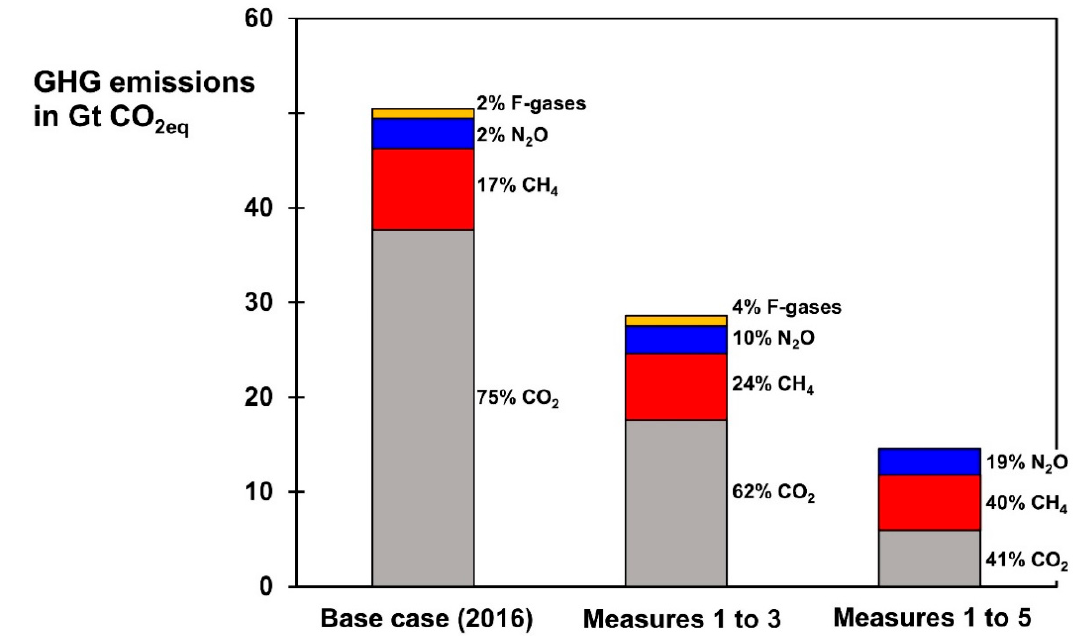
Figure 3. Global GHG emissions and shares of CO 2 , CH 4 , N 2 O and F-gases in base case (2016) and if measures 1 to 3 or 1 to 5 are taken (constant global population and prosperity).